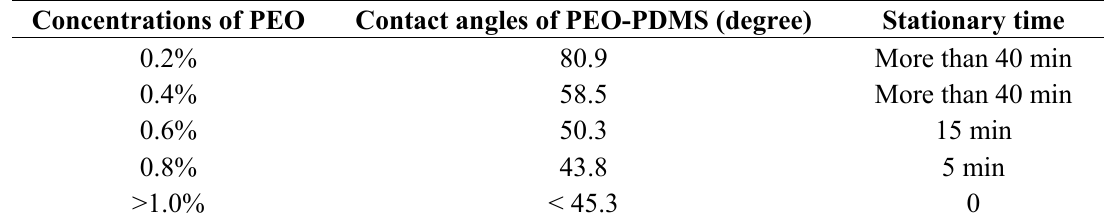
Table 3. The fluid stationary time for the stop valves with the same 170° expansion angle and the PEO-PDMS covers in five different PEO concentrations Concentrations of PEO